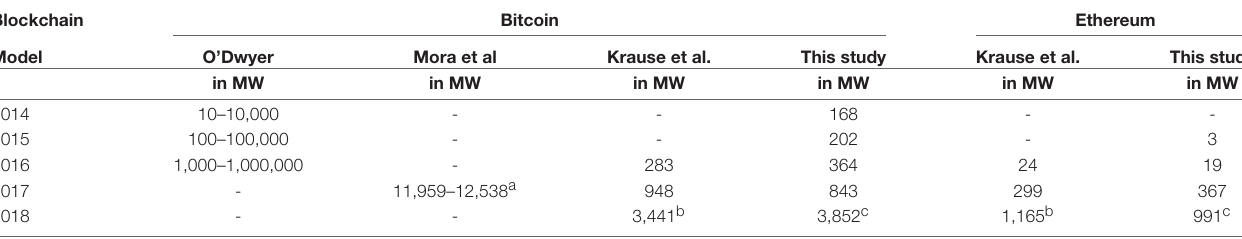
TABLE 4 | Annual average powerdemand of bitcoin and ethereum. Blockchain